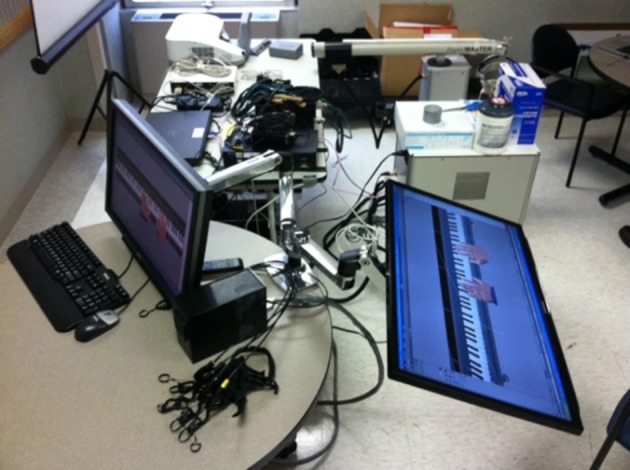
NJIT-RAVR system.